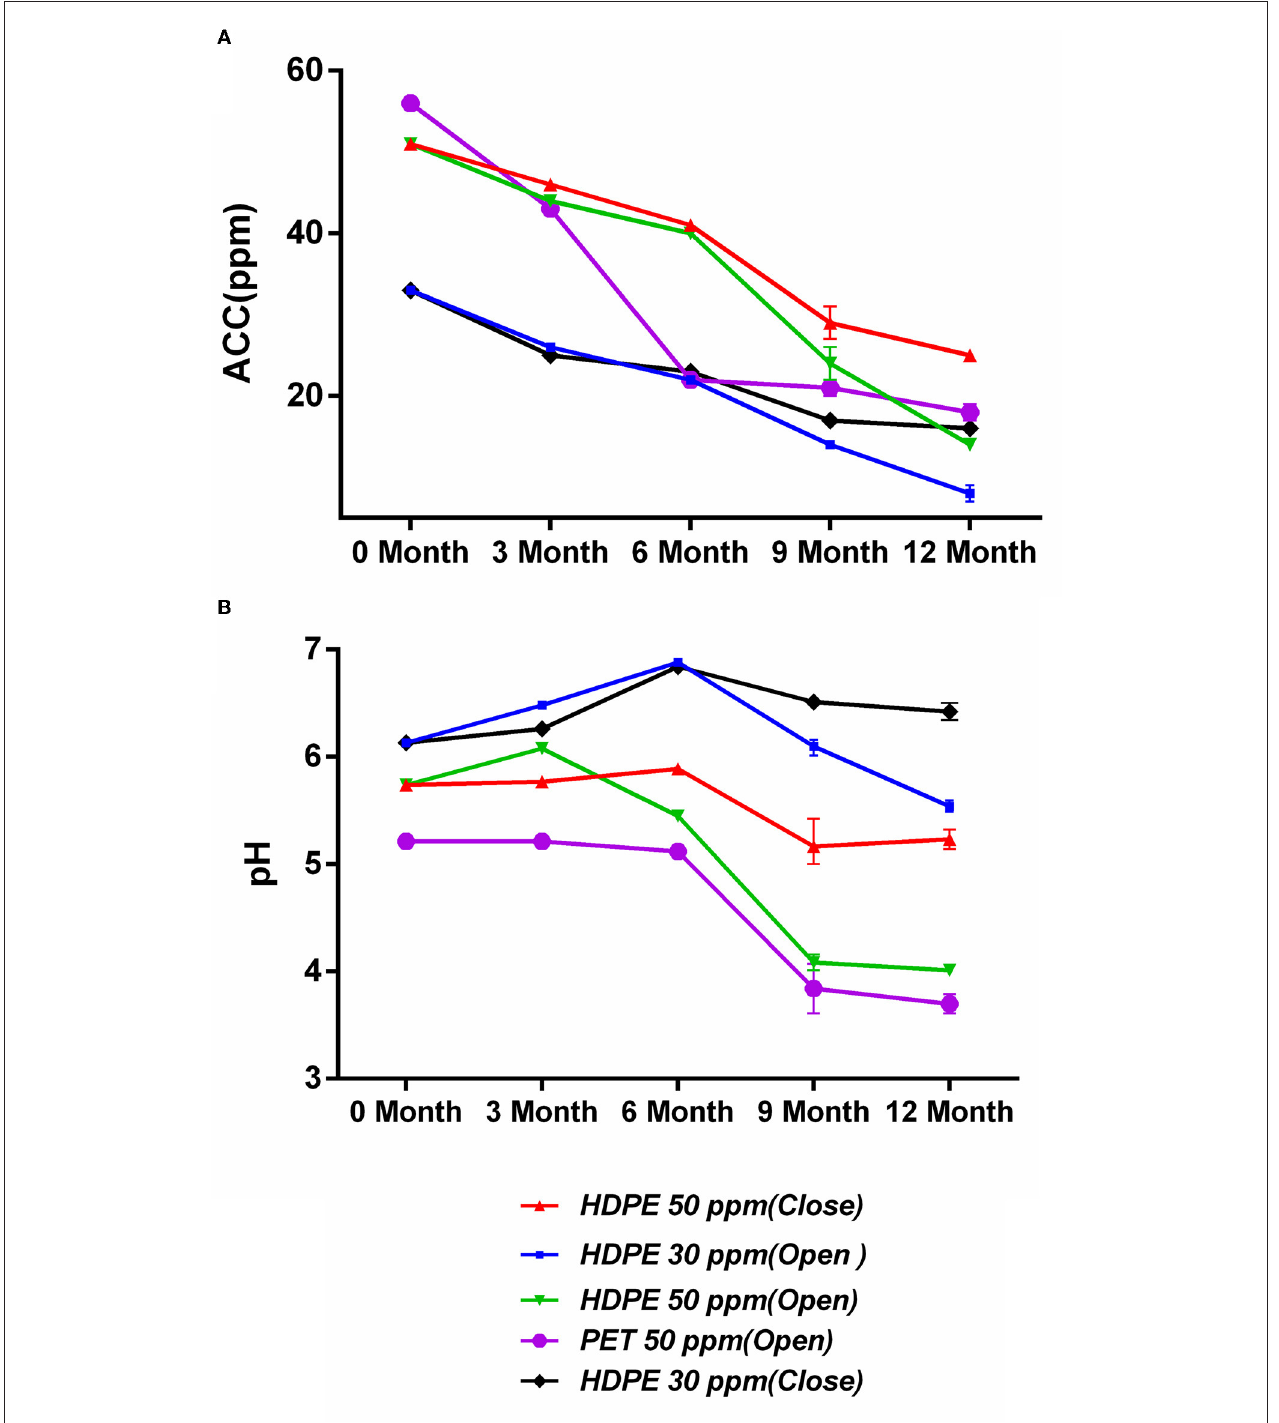
FIGURE 2 | (A,B) Effect of storage condition on available chlorine concentration (ppm) and pH of SAEW during 12-month storage. Values are expressed as the means ± standard deviations ( n = 3).